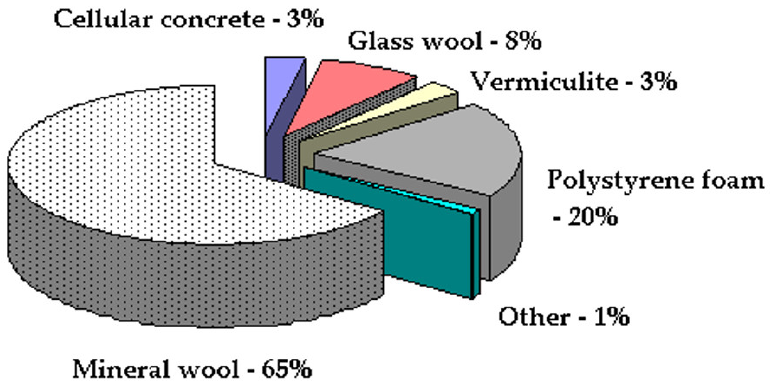
Figure 1. World market of insulation materials.